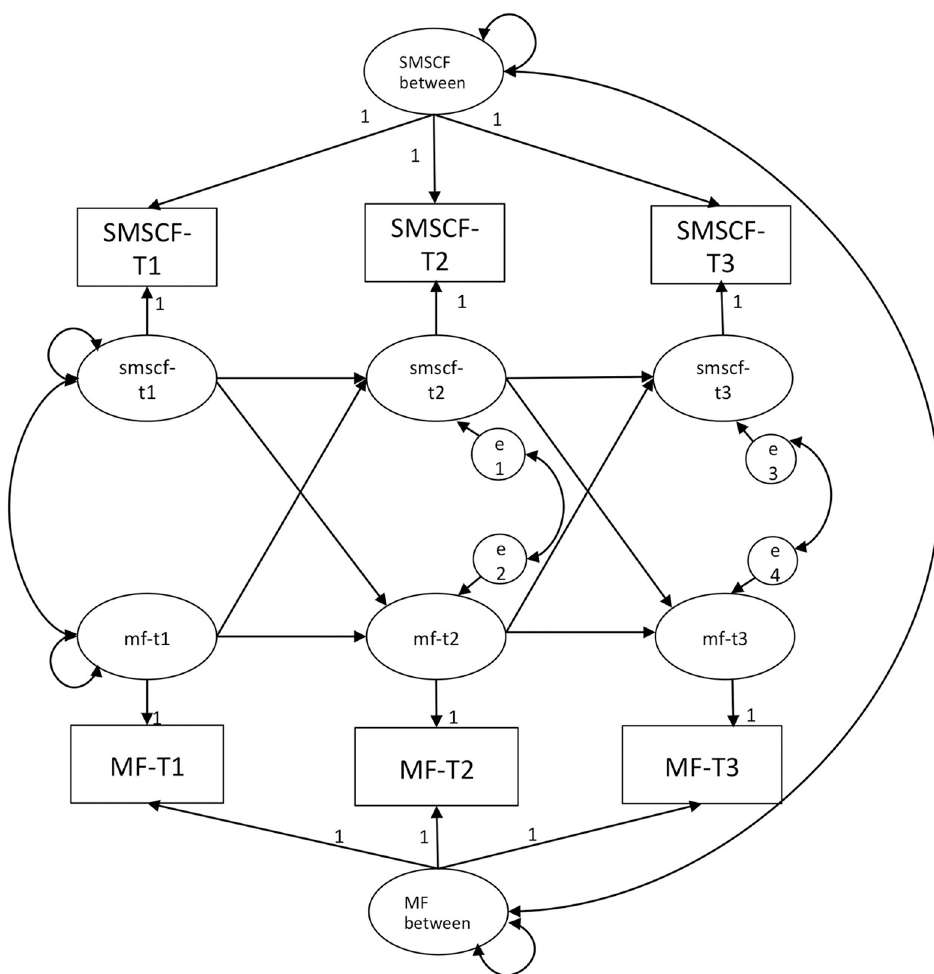
Fig 1. Random intercept cross-lagged panel model of social media self-control failure and mindfulness. smscf/ SMSCF = Social media self-control failure, mf/MF = Mindfulness.